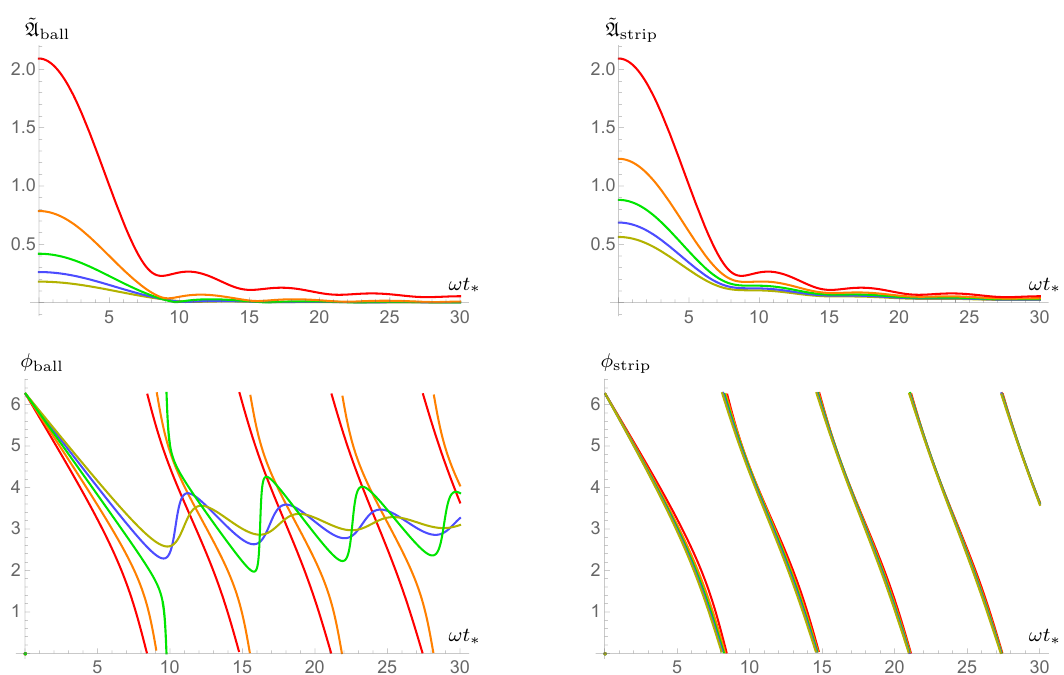
Figure 6 . Normalized amplitude ~ A two geometries of interest: the ball and the strip. The various lines correspond to d = depicted in red, orange, green, blue and yellow,